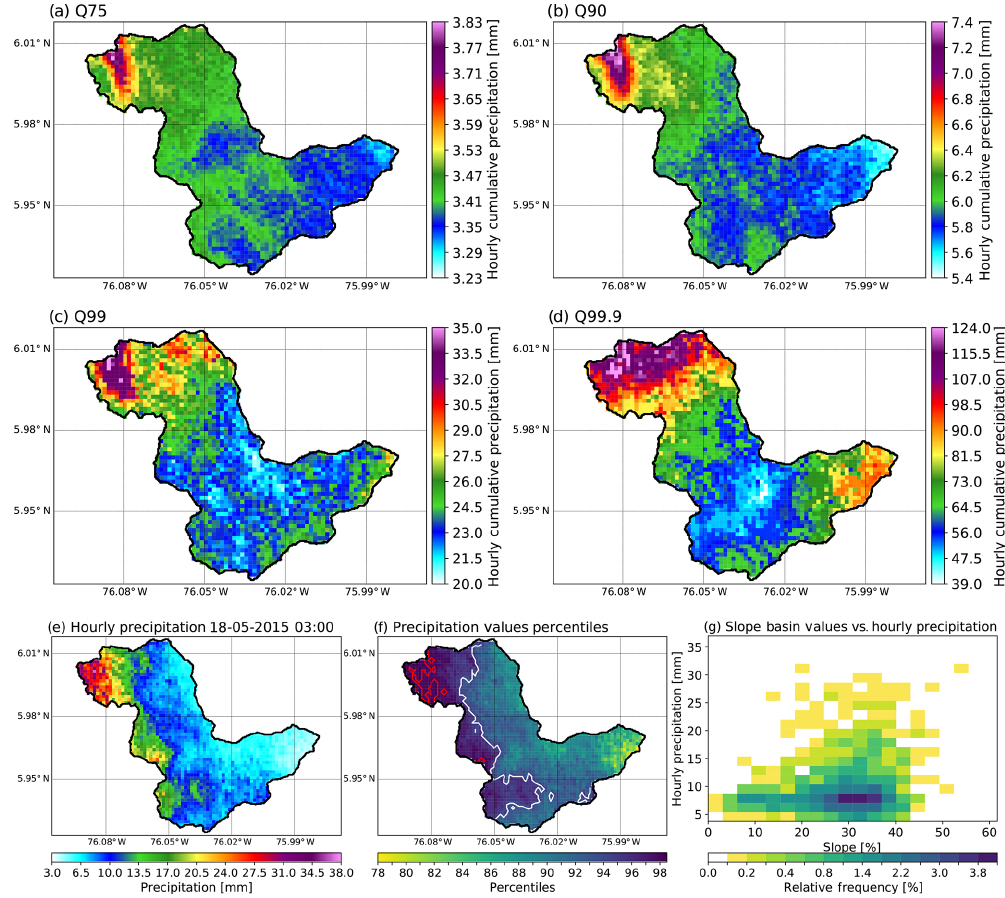
Figure 18. (a–d) Spatial distribution of the 75th, 90th, 99th, and 99.9th hourly cumulative precipitation percentiles, respectively, for the La Liboriana basin. (e) Hourly cumulative precipitation during the hour of the flash flood, from 02:00 to 03:00LT during 18 May 2015, including evidence of the intensification towards the upper basin. (f) Spatial distribution of the corresponding hourly percentile for the cumulative precipitation in (e) . The continuous white (red) line corresponds to the 95th (99th) percentile. (g) Bivariate histogram of the hourly cumulative precipitation in (e) and the slopes in the